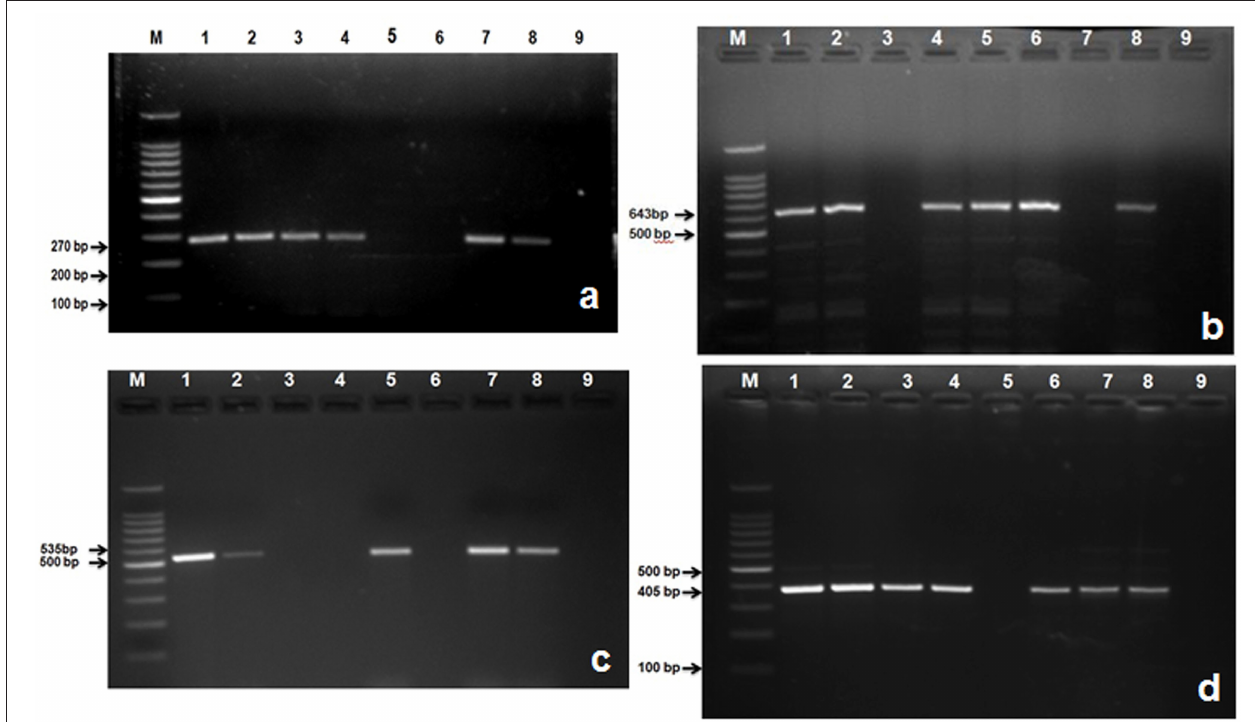
FIGURE 4 | Amplified PCR products of S. aureus and S. agalactiae genes isolated from mastitis milk samples. (a) PCR product of nuc gene at 270 bp. Lane M: 100 bp ladder; Lane 1: positive control; Lanes 2, 3, 4, 7, and 8 are nuc gene positive; Lane 5, 6: are nuc gene negative; Lane 9: negative control; (b) PCR product of seb gene at 643 bp. M: 100 bp ladder; Lane 1: positive control; Lanes 2, 4, 5, 6, and 8 are seb gene positive; Lane 3, and 7: are seb gene negative; Lane 9: negative control; (c) PCR product of hla gene at 535 bp. M: 100 bp ladder; Lane 1: positive control; Lanes 2, 5, 7, and 8 are hla gene positive; Lane 3, 4, and 6: are hla gene negative; Lane 9: negative control; (d) Lane M: 100 bp ladder; Lane 1: positive control; Lanes 2, 3, 4, 6, 7, and 8: are S agl gene positive; Lane 5: is S agl gene negative; Lane 9: negative